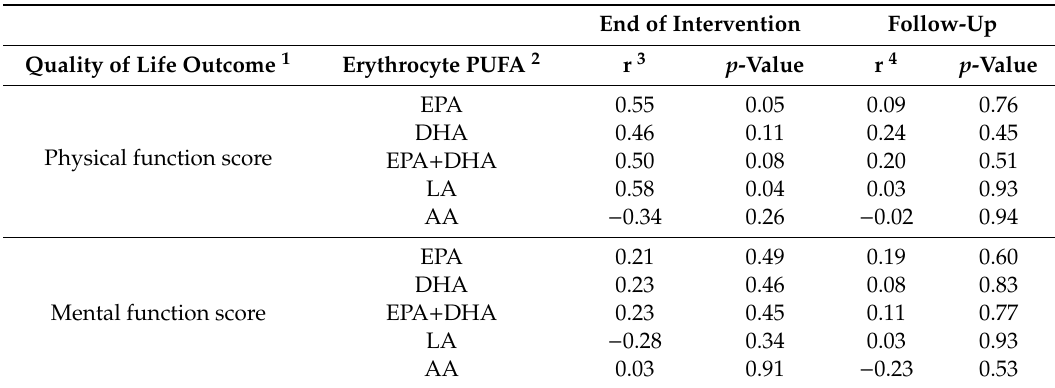
Table 6. Associations between quality of life indicators and erythrocyte polyunsaturated fatty acids (PUFA), adjusting for % weight change, among fourteen post-menopausal women completing the LASO-3